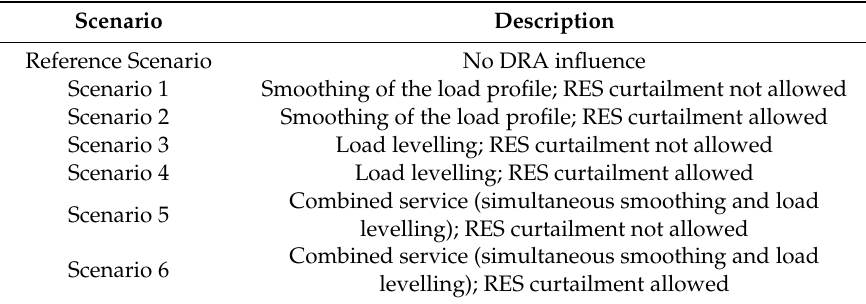
Table 3. Description of the simulation scenarios.